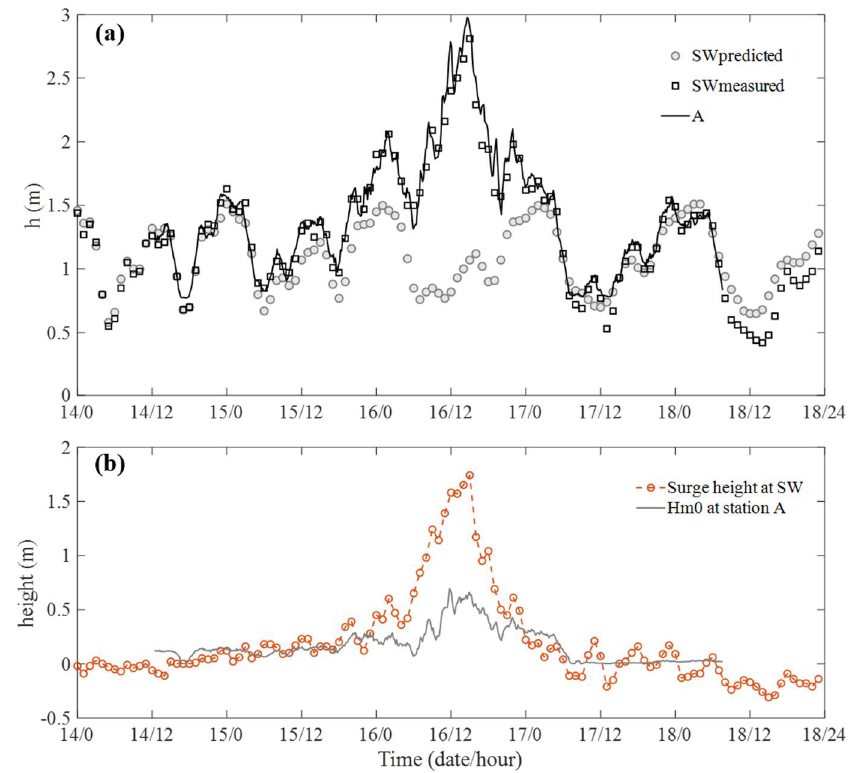
Figure 3. ( a ) Water depth, h , at station A (black curve) and the predicted tidal level (circles) and measured water depth (squares) at Shanwei tide gauge station (SW, data obtained at http://global- tide.nmdis.org.cn/, accessed on 15 December 2021). Note that a 0.44 m difference was added to h at station A considering the difference in the zero-elevation reference. ( b ) The storm surge height (i.e., the difference between the measured water depth and predicted tidal level) at SW and the significant wave height at station A.